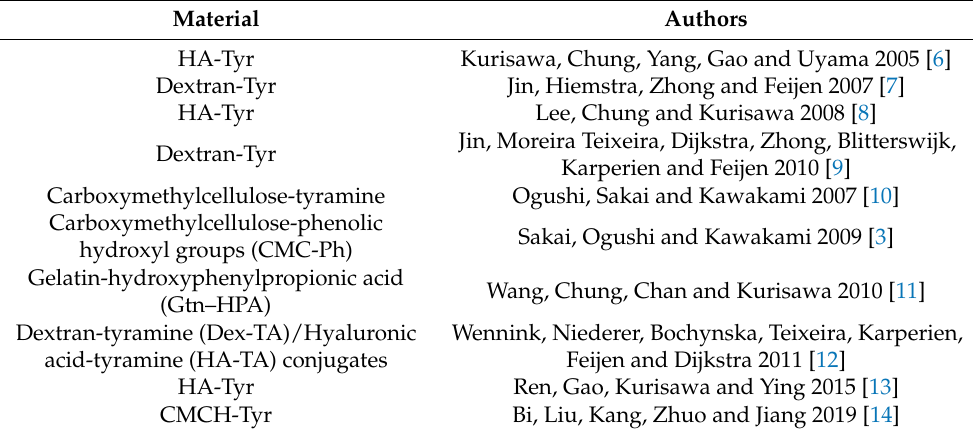
Table 1. Selected papers on HRP/H 2 O 2 crosslinked polymer–phenol systems for biomedical